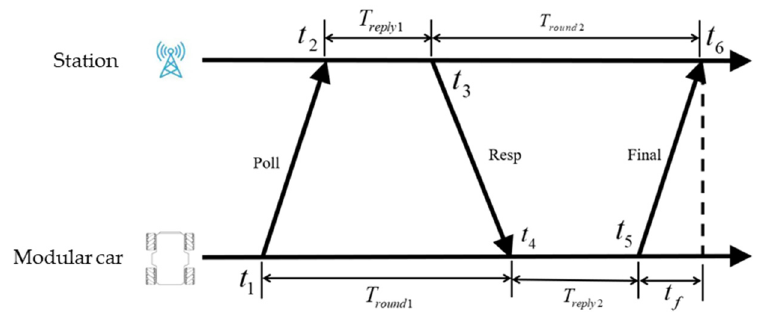
Figure 6. Bidirectional bilateral ranging.